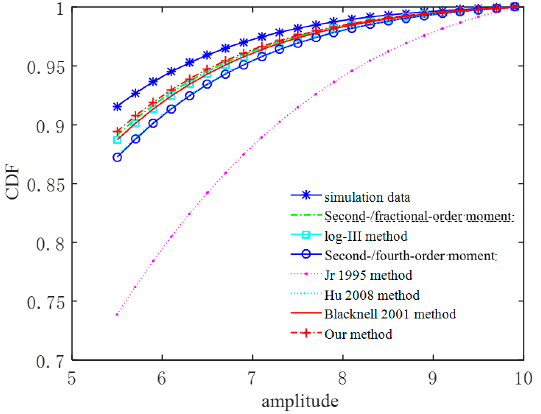
Figure 3. The tail fitting of the K-distribution.